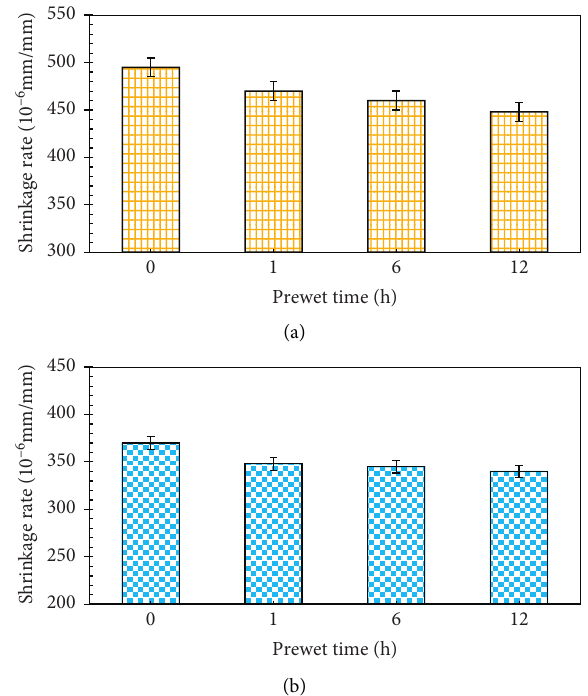
Figure 13: Shrinkage rate for concrete at 56d (a) without SRA and (b) with SRA